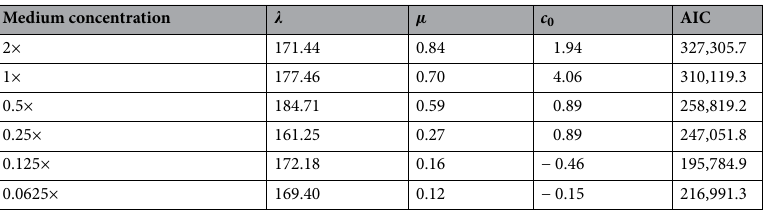
Medium concentration